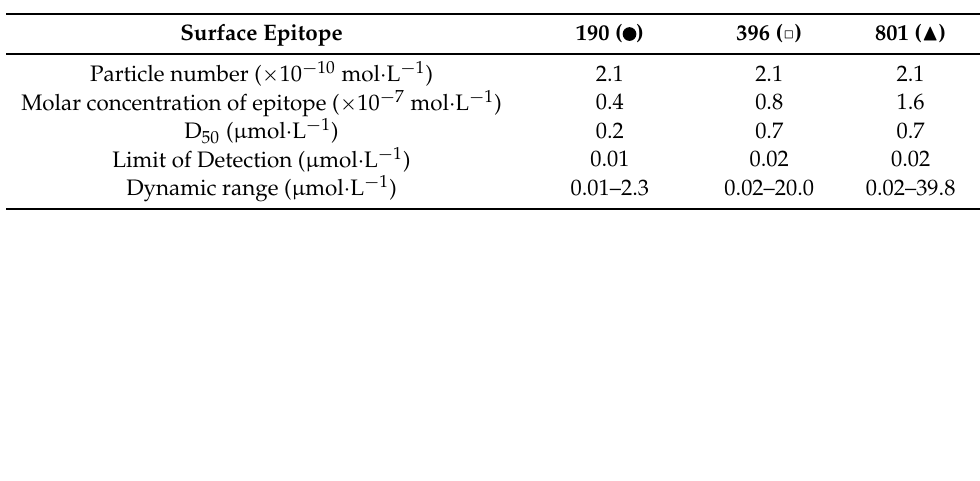
Table 2. Displacement assay parameters derived from Figure